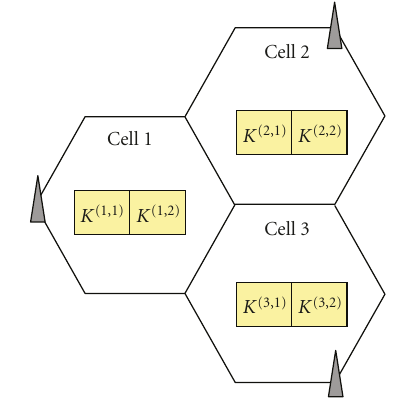
Figure 1: Three-cell network with two assignment